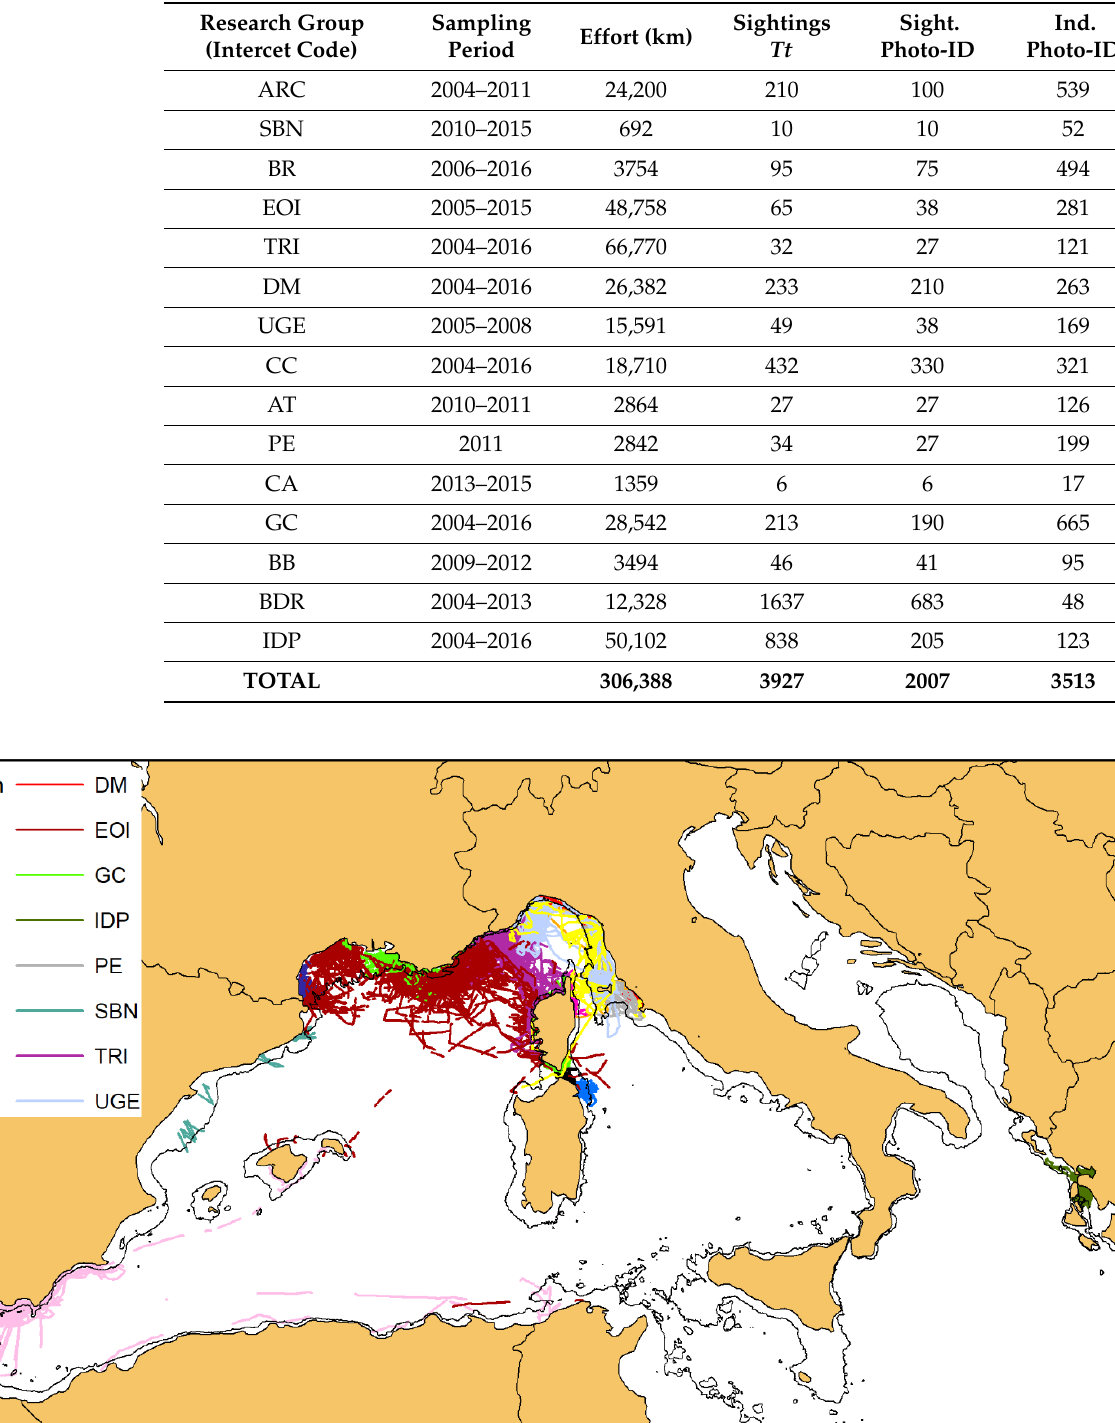
Figure 3. Sighting points of bottlenose dolphins from the different research groups involved (see also Tables 1 and 2). 3.2. Photographic Data and Matching Process